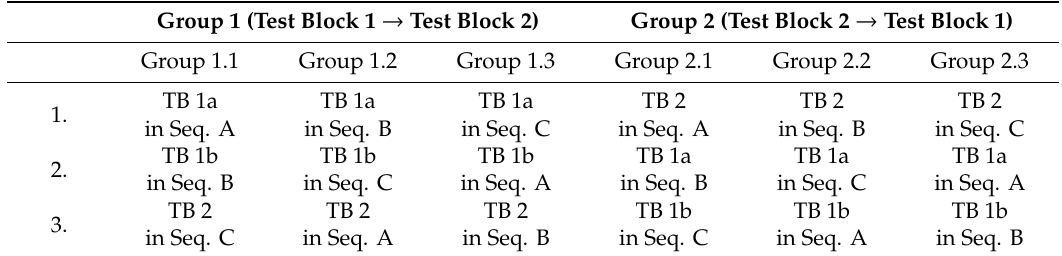
Table 3. Example of the experimental design with di ff erent sequences of test blocks and use